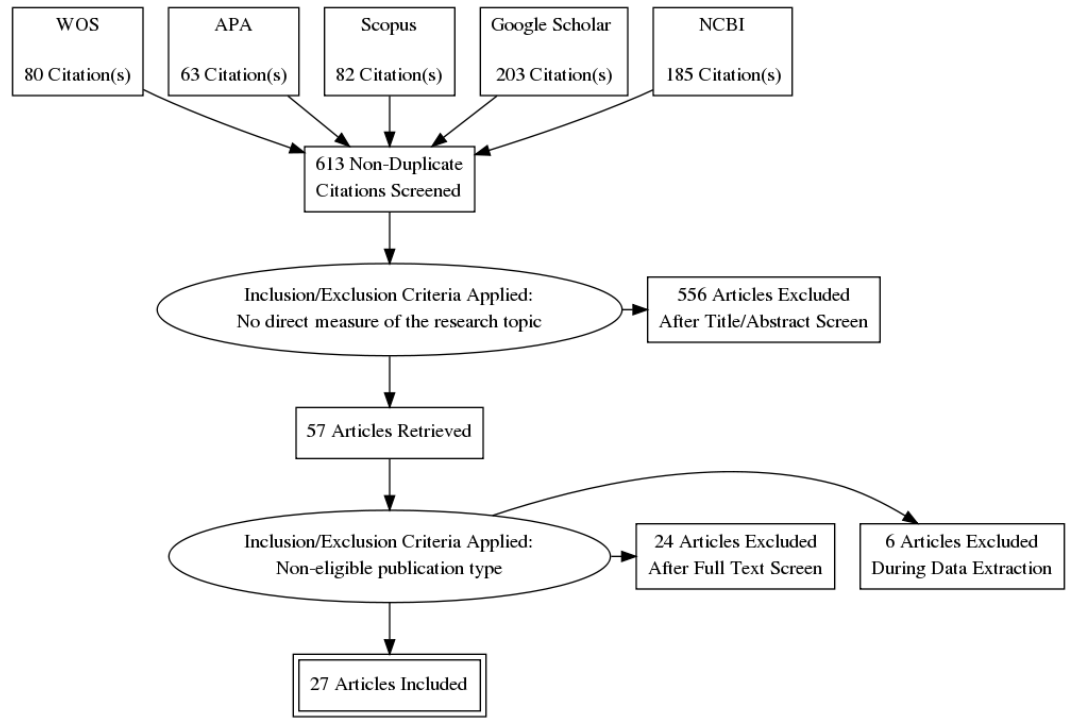
Figure 1. PRISMA diagram. Abbreviations: WOS (Web of Science); APA (American Psychological Association).